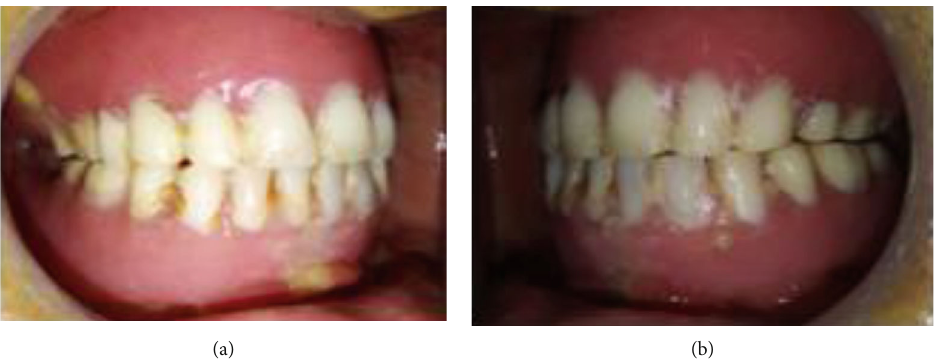
Figure 13: Misadjusted occlusion: (a) right side and (b) left side.